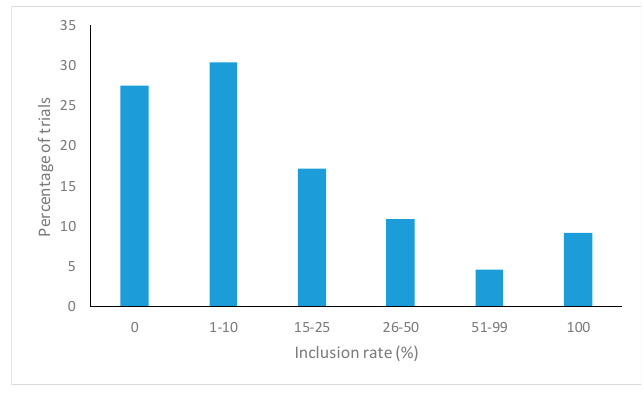
Figure 1. Inclusion rates of insects in the diet of poultry in the trials included in the Figure 2. Repartition of studies included in the meta-analysis per continent and per year of publication.